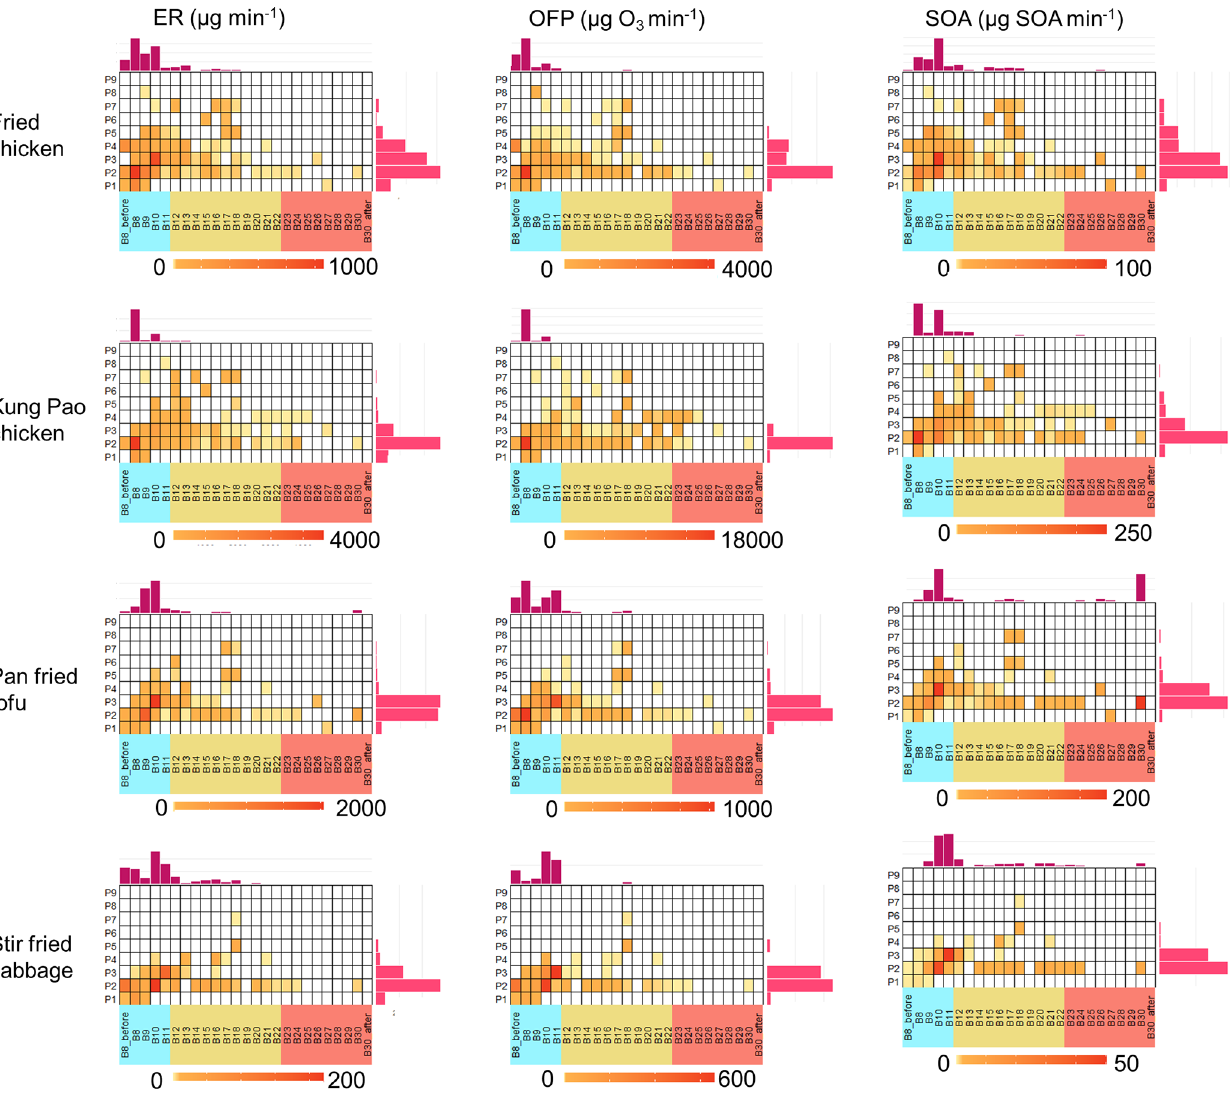
Figure 3. Volatility–polarity panels of gaseous chemical emissions from fried chicken, Kung Pao chicken, pan-fried tofu, and stir-fried cabbage fumes, and ozone formation potential (OFP), and secondary organic aerosol (SOA) estimation from gas-phase precursors. VOCs (blue colour in x axis), IVOCs (orange colour in x axis), and SVOCs (red colour in x axis) are displayed in volatility bins (a decrease of volatility from B8 to B31) along with their polarity (an increase from P1 to P10 in y axis). The emission rate (ER) unit is µgmin − 1 .